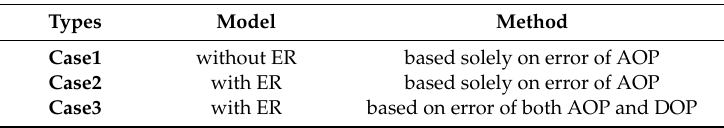
Table 3. Description of the three cases.